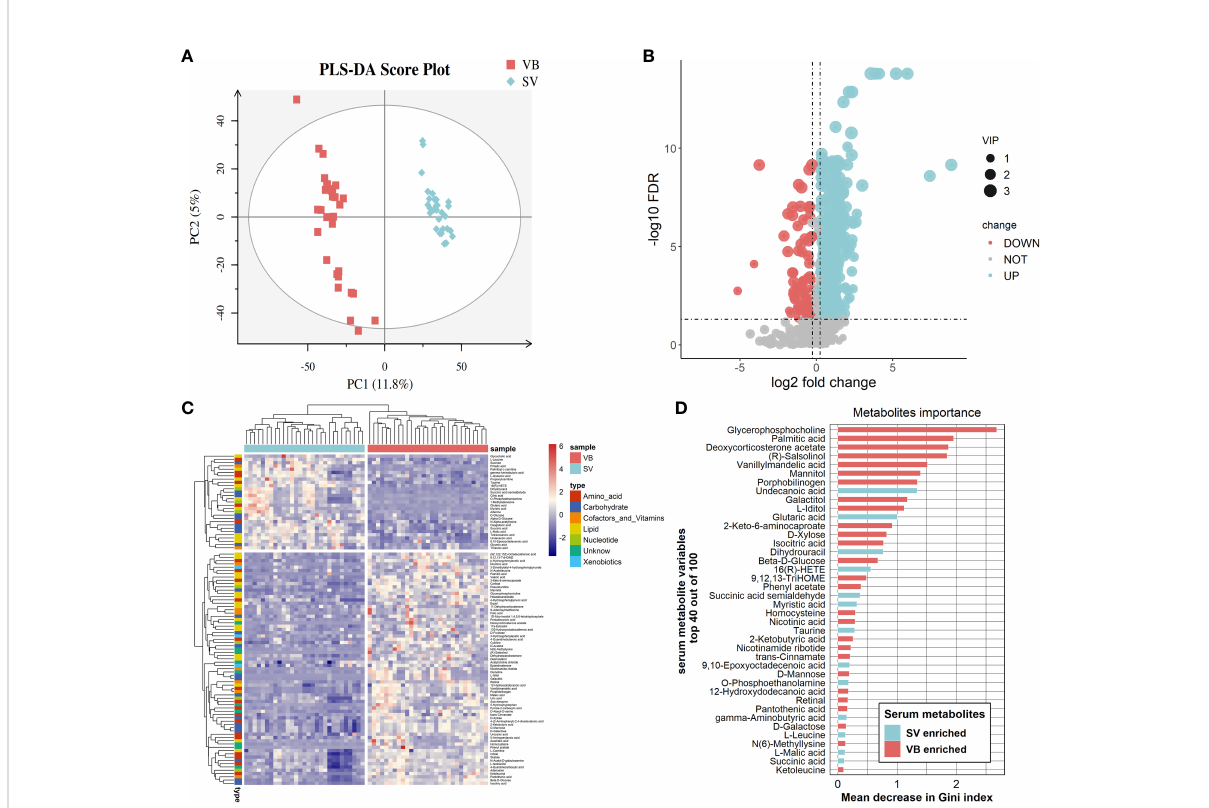
FIGURE 2 Alteration of main metabolites in sera samples from the vaccinated individuals. (A) Partial least squares discriminant analysis score plot based on the VB and SV groups. (B) Volcano plots highlight the serum metabolites that were increased (red) in the SV compared to the VB group, with FDR < 0.05, log2 fold change (FC) >0.25 or < − 0.25. (C) Heatmap clustering of distinct serum metabolites from the comparison between the VB and SV groups. (D) Variable importance plot of the top 40 serum metabolites (y-axis) ranked by the contribution to mean decrease accuracy of the Gini coef fi cient (x-axis) in the random forest model for discerning group